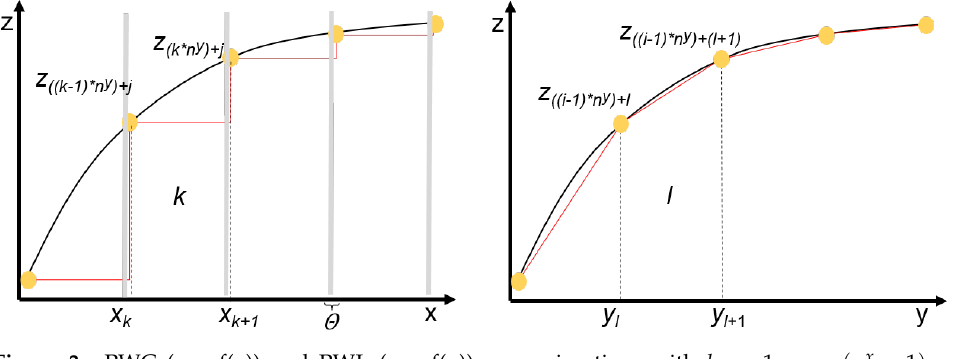
Figure 3. PWC (z = f(x)) and PWL (z = f(y)) approximation, with k = 1, . . . , ( n x − 1 ) and l = 1, . . . , ( n y − 1 ) . The two newly introduced indices k and l index the areas, whereas i and j are used to index the breakpoints and function values (Section 2.2.1). By selecting the area k or l , the upper and lower limits stored in x , y , and z can be accessed (Section 2.3.1).